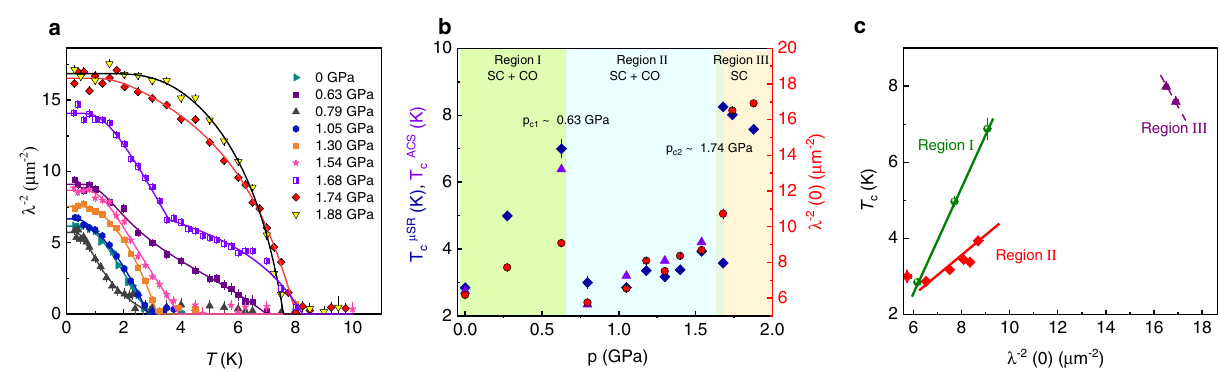
Fig. 2 Pressure dependence of the superconducting parameters and temperature-pressure phase diagram. a Temperature variation of the inverse squared magnetic penetration depth λ − 2 ( T ) for the applied hydrostatic pressures shown in the plot legend. The solid line is a two gap s + s -wave model fi tting using the phenomenological α -model. b The temperature-pressure superconducting phase diagram of CsV obtained through TF- μ SR and ac magnetic susceptibility measurements carried out under hydrostatic pressure conditions. The right axis presents the inverse squared London penetration depth at base temperature, i.e., λ − 2 (0) ∝ n s as a function of pressure. c Superconducting transition temperature T c plotted as a function of the base-temperature super fl uid density λ − 2 (0) for the three different regions of the phase diagram of b . The error bars represent the standard deviation of the fi